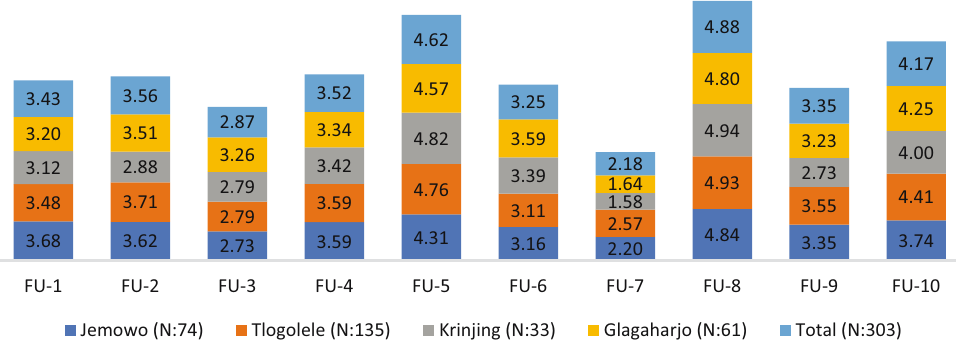
Figure 3: Mean of each indicator of food utilization. FU - 1 ( cannot eat healthy and nutritious food ) ; FU - 2 ( consumption only of limited kinds of food ) ; FU - 3 ( eating meat in a week ) ; FU - 4 ( eating eggs in a week ) ; FU - 5 ( eating vegetables in a week ) ; FU - 6 ( eating fruits in a week ) ; FU - 7 ( eating corn in a week ) ; FU - 8 ( eating rice in a week ) ; FU - 9 ( eating tubers in a week ) ; and FU - 10 ( eating beans in a week